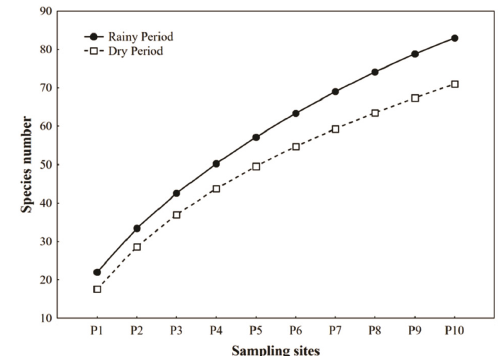
Figure 6. Graphic representation of the species increment in the Paraná River towards